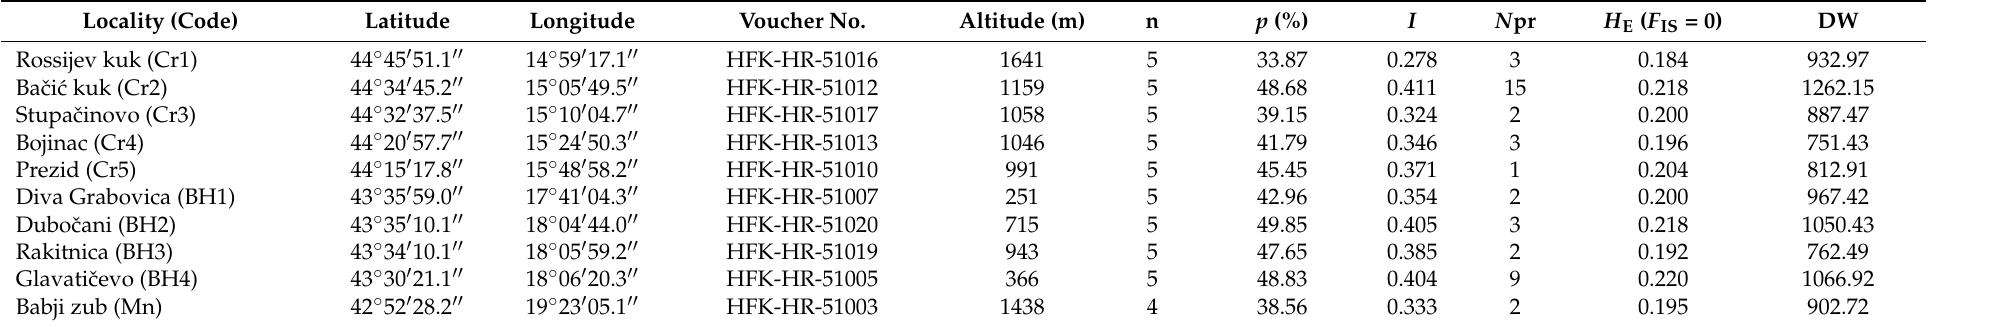
Table 2. Details on origin and collection data and molecular diversity revealed by AFLP markers in ten Micromeria croatica populations from. Croatia (Cr1–Cr5), Bosnia and Herzegovina (BH1–BH4), and Montenegro